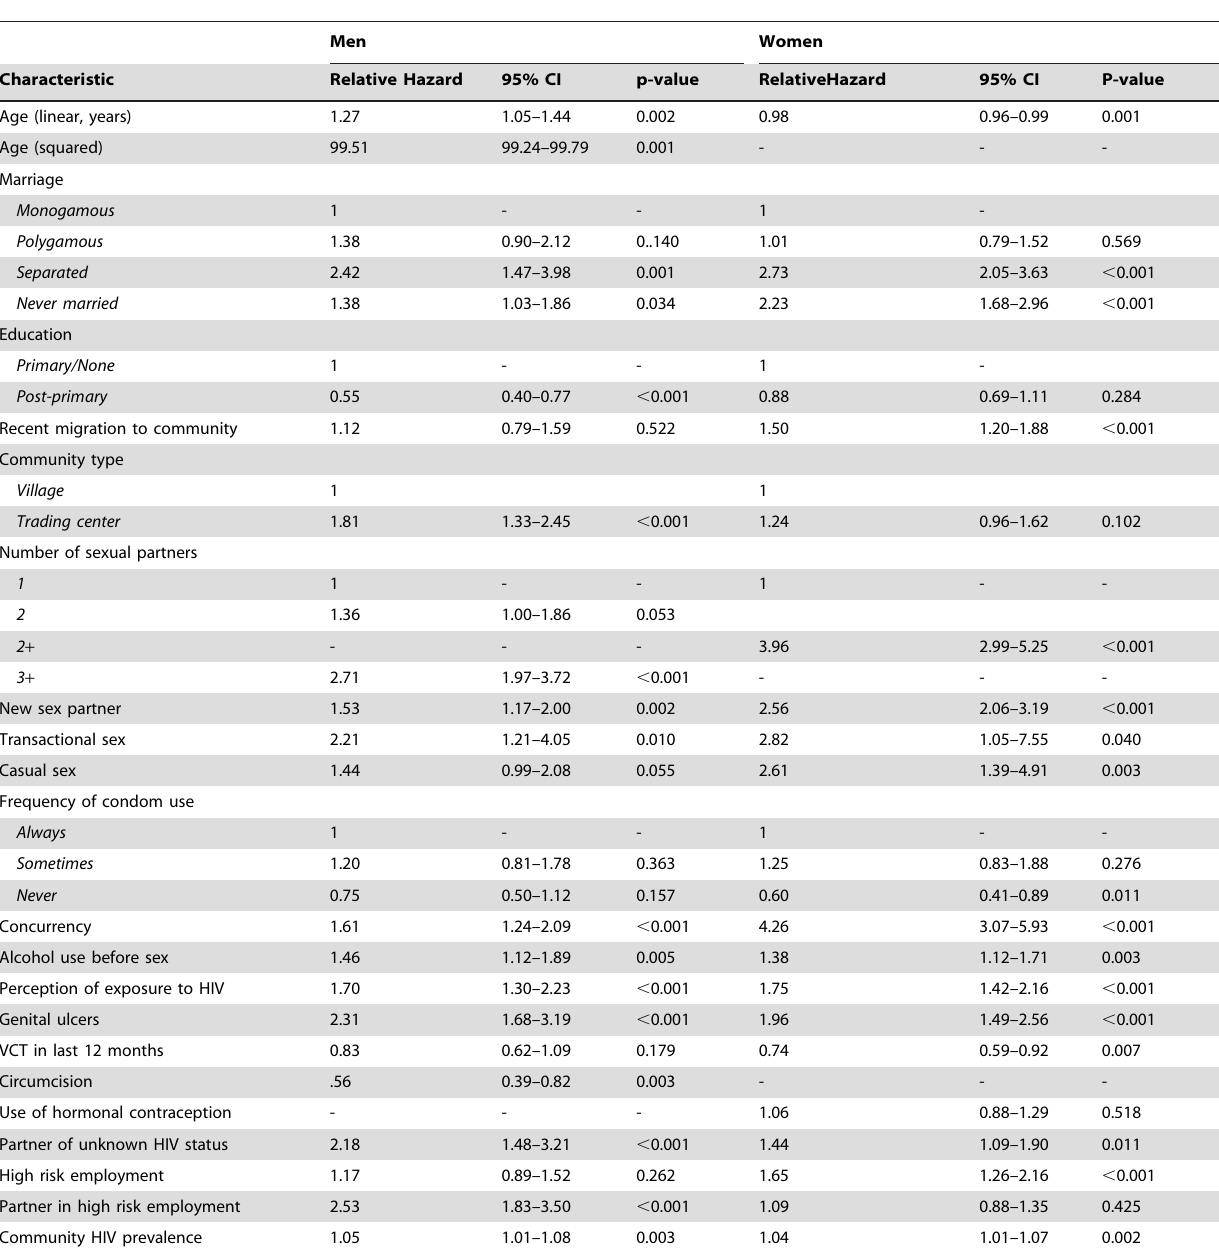
Table 3. Association between variables and HIV acquisition by Gender, Rakai, Uganda 2003–2011: Unadjusted